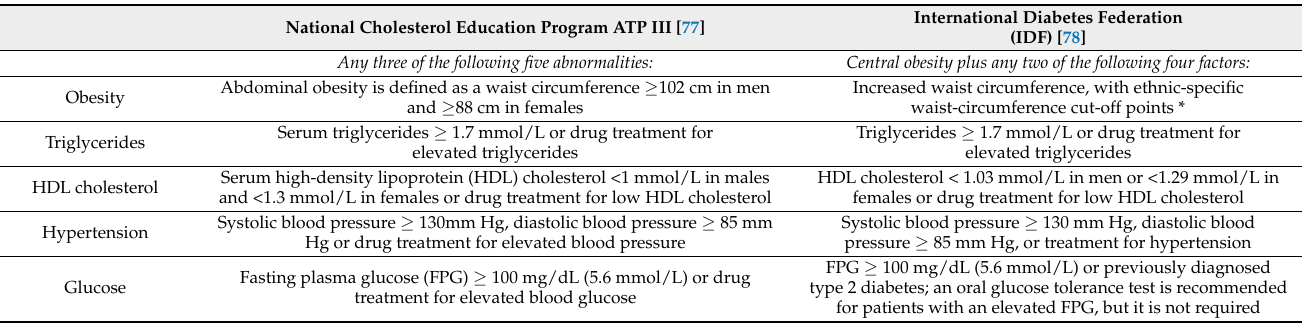
Table 1. Criteria for the definition of metabolic